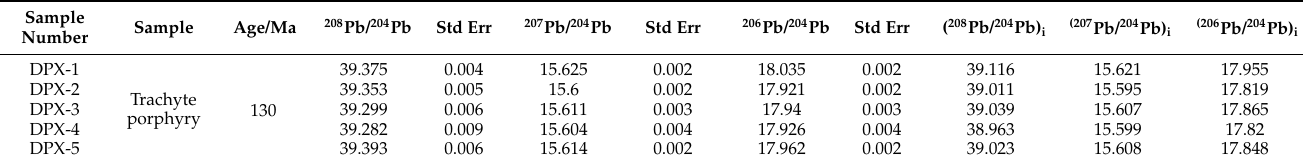
Table 5. Pb isotopic data of trachyte porphyry in the Dongpuzi gold deposit.